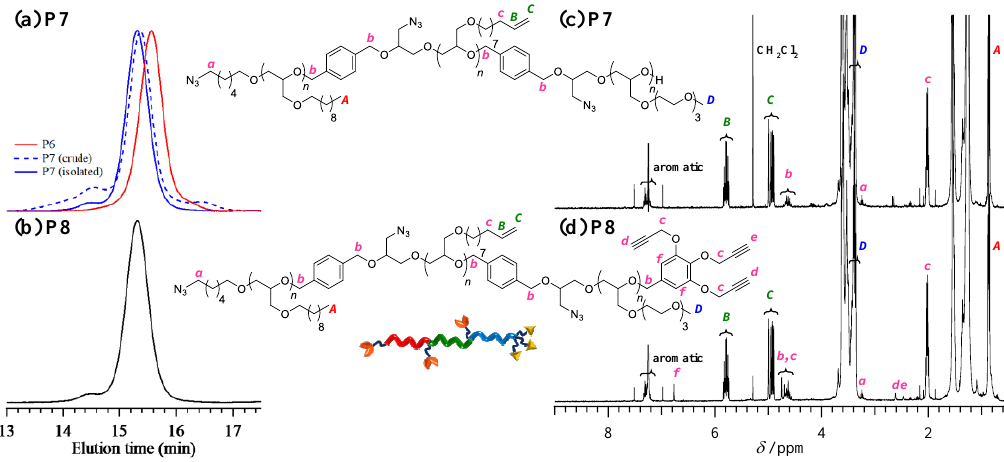
Figure 3. ( a , b ) SEC traces of P7 (dotted line, before purification; solid line, after purification using